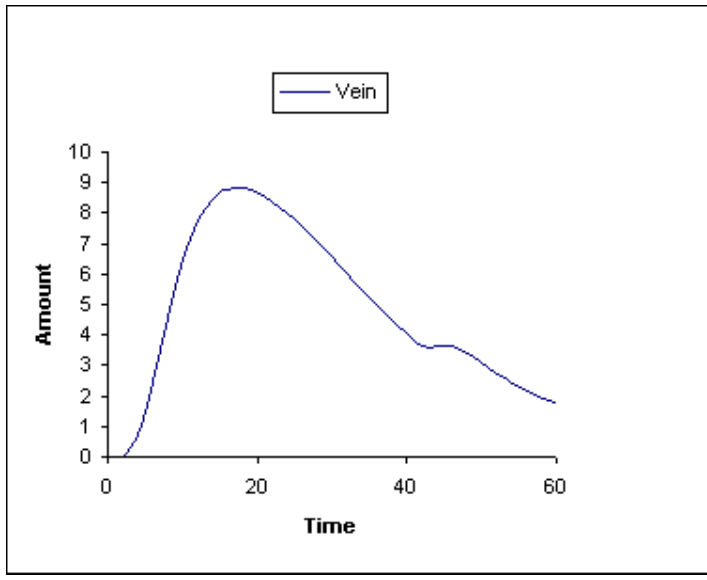
FIGURE 11 . Simulation of blood concentration-time curve after an oral drug dose showing a second maximum due to enterohepatic recirculation.